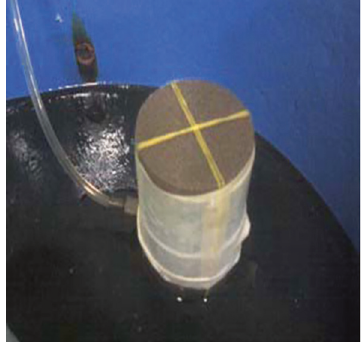
Figure 5: Modified apparatus constructed.